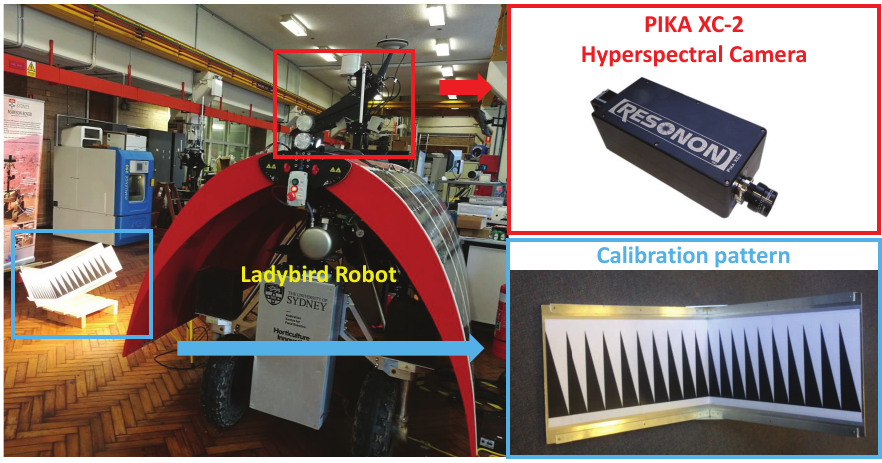
Figure 12. The experimental setup of the hyperspectral line-scan camera